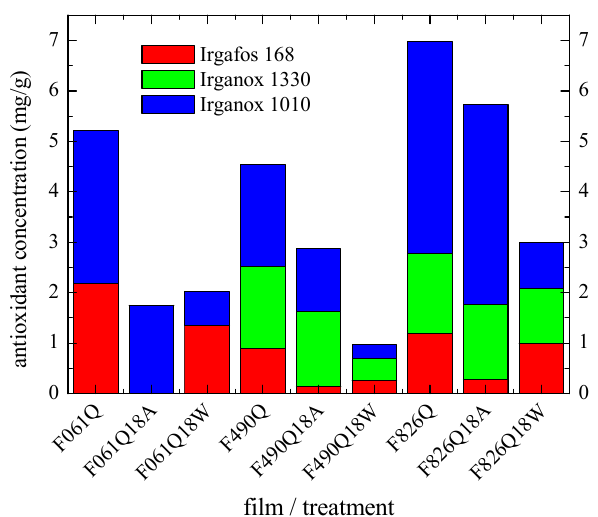
Figure 10. Influence of the aging environment media on the consumption of additives.